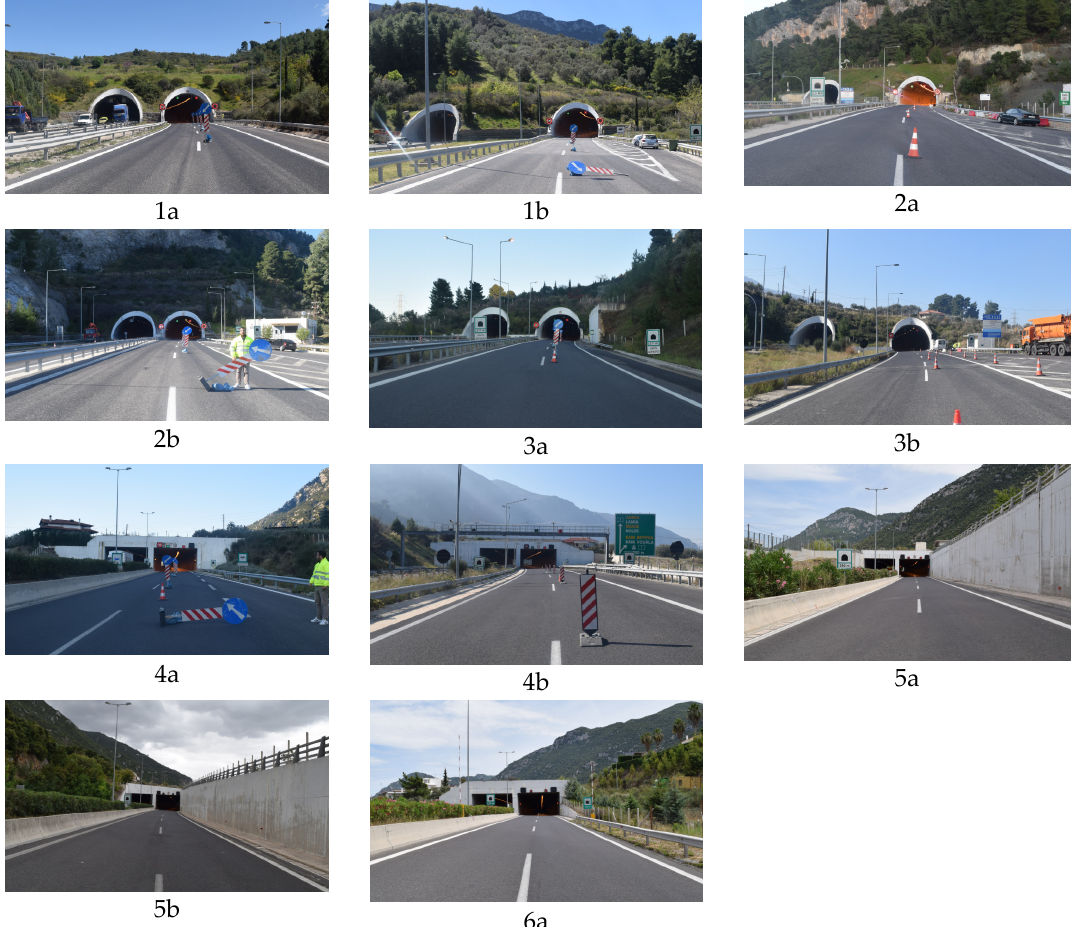
Figure 2. The 11 examined tunnels along the national motorway Patra-ATHens-Efzoni (PATHE) in Greece.